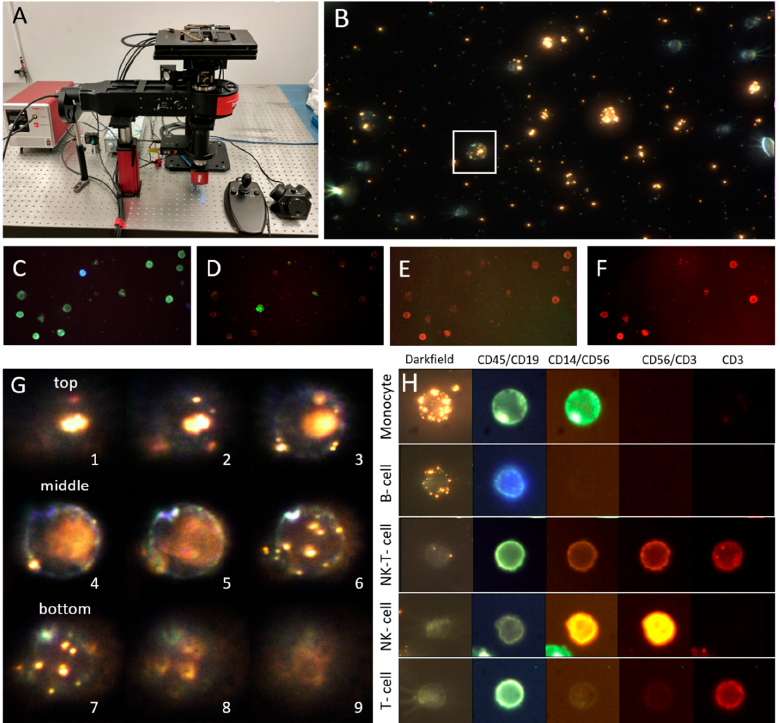
Figure 1. Microscopy system and example images of PBMC from a healthy control. ( A ) Combined automated darkfield and epi-fluorescence microscope developed for the project. ( B ) Maximum- intensity projection of the z-stack darkfield image of a field of view. Some cells show PNPs bound to them. ( C ) First fluorescent channel showing all PBMC in green (CD45) and B cells in blue (CD19). ( D ) Second fluorescent channel showing monocytes in green (CD14) and NK cells in orange (CD56). ( E ) Third fluorescent channel showing NK cells in orange (CD56) and T cells in red (CD3). ( F ) Fourth fluorescent channel showing T cells in red (CD3). ( G ) Representative slices of the z-stack of the monocyte highlighted in B. Please observe how PNPs are visible on the planes of the cell that are above (top) and below (bottom) its equatorial plane (middle), located in the center of the inset. This is due to the high brightness of the plasmonic nanoparticles and the transparency of the cells under darkfield. Numbers indicate the order of the image in the z-stack. ( H ) Composite image showing the darkfield maximum-intensity projection and 4-channel fluorescence of example cells of different lineages. Please observe how, for these examples, the monocyte exhibits high CA125 binding, the B-cell medium CA125 binding and other cell classes show no